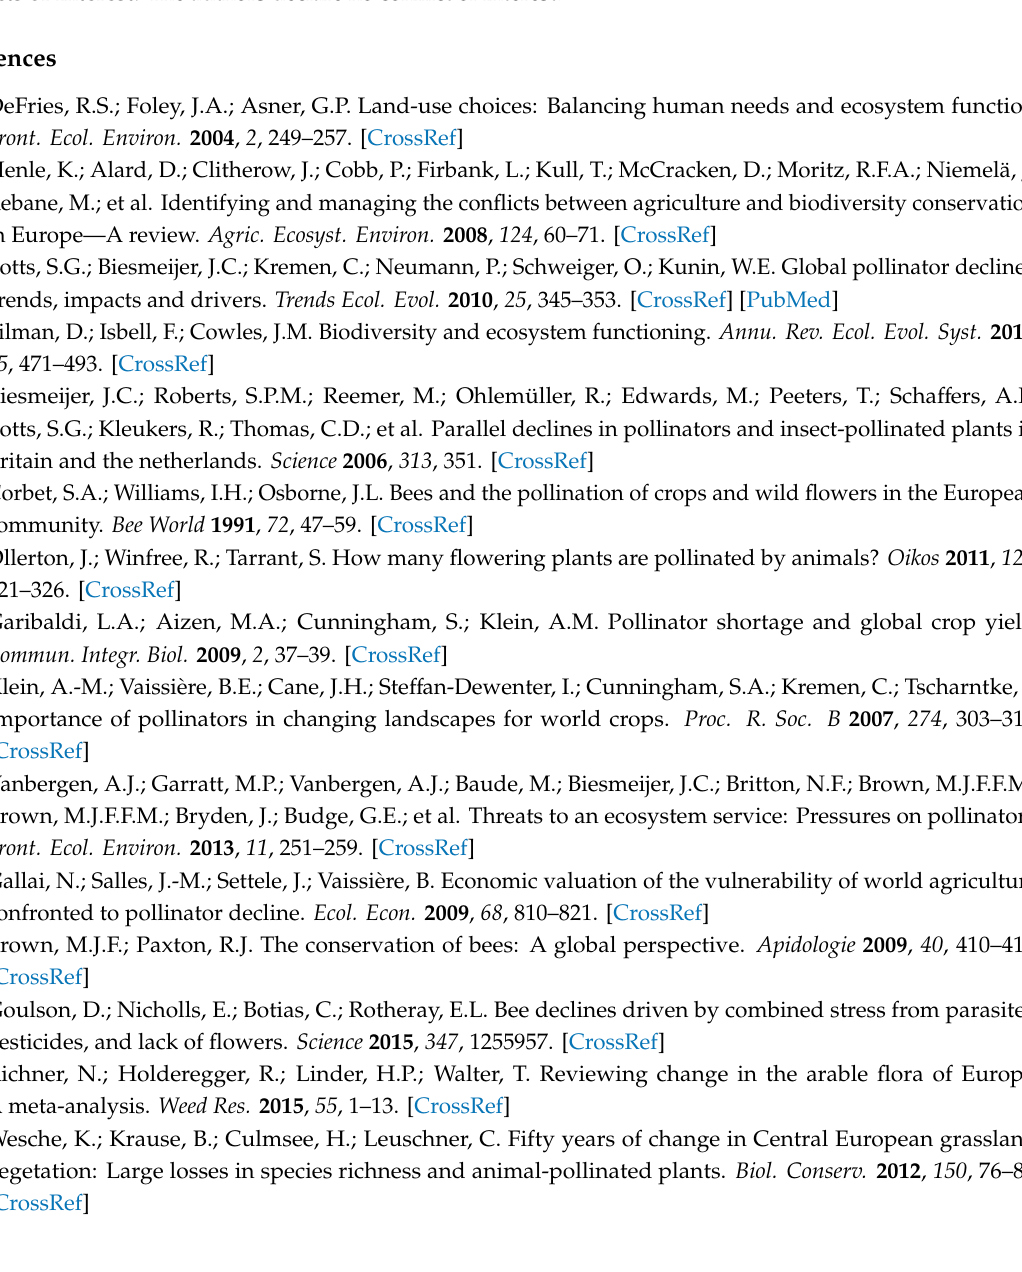
Figure S1: Plant species contribution to total nectar supply on each landscape element. Lines show the